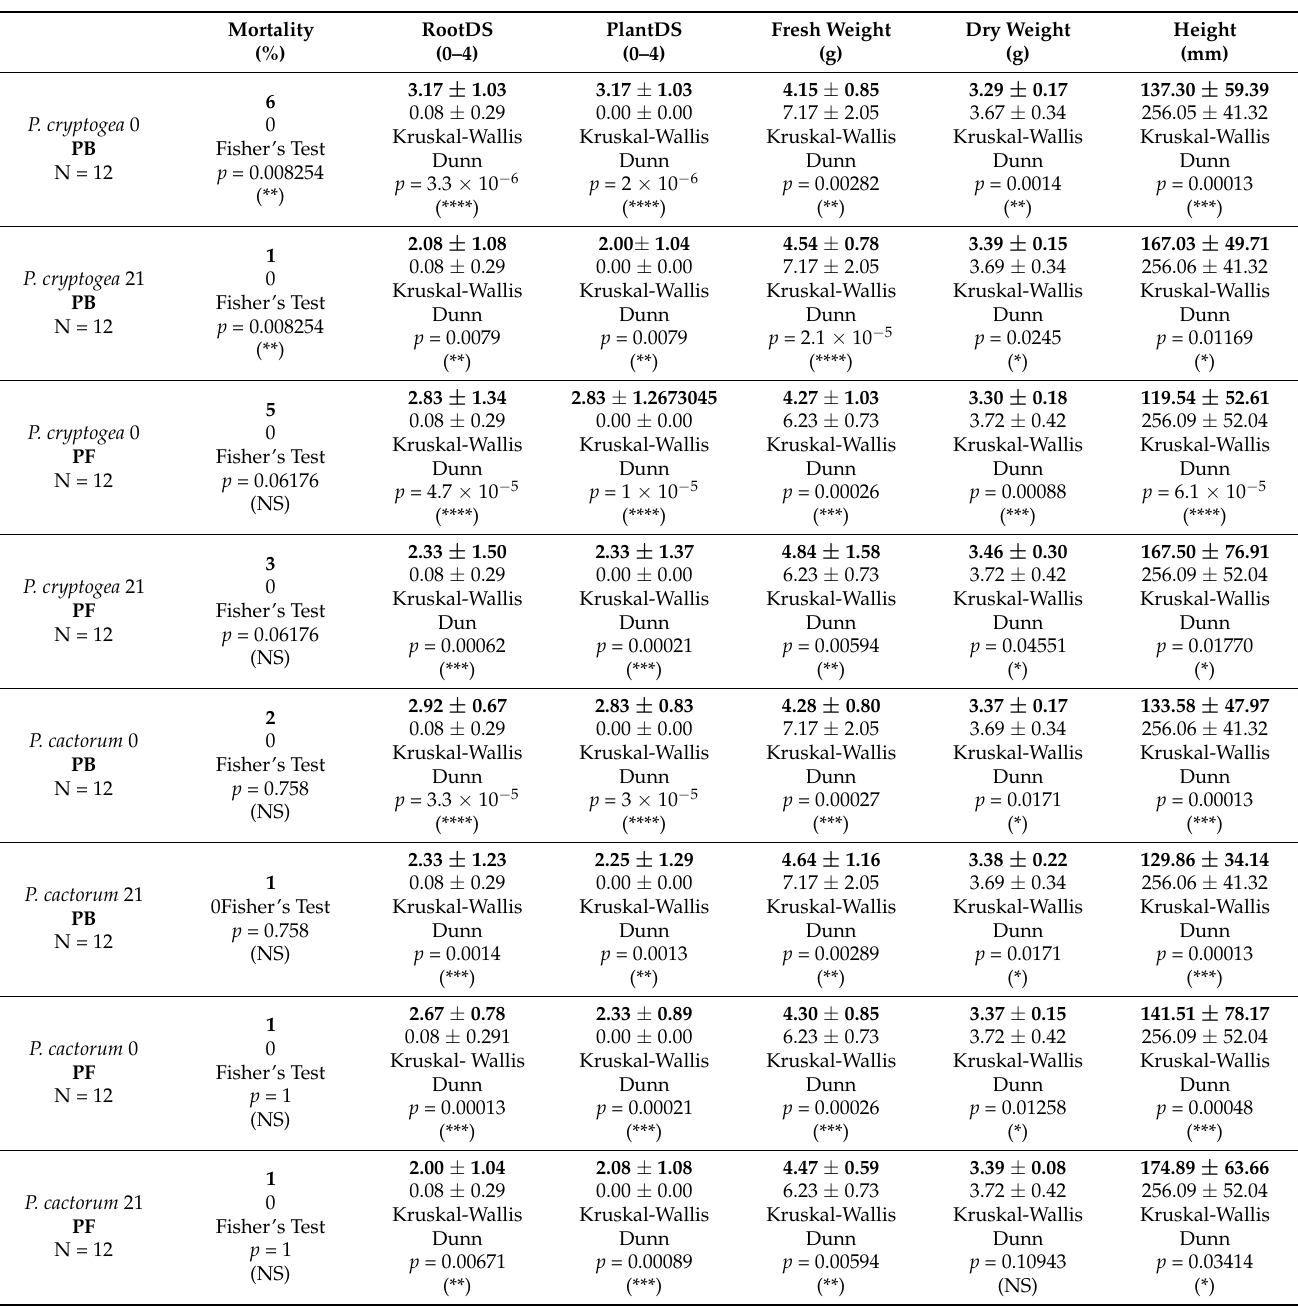
Table 2. Soil inoculation tests comparing plant mortality, foliar symptoms, root disease severity, plant height, and fresh and dry weights for Eucalyptus globulus in substrates Phytophthora cryptogea 21 (21 months after inoculation), P. cryptogea 0 (freshly inoculated), P. cactorum 21 (21 months after inoculation), and P. cactorum0 (freshly inoculated) (rows in bold) compared with controls. Data are means ± SD for each factor and the p-value (for mortality, sample proportions are shown instead of the mean and SD). NS means p > 0.05, * means p ≤ 0.05, ** means p ≤ 0.01, *** means p ≤ 0.001, **** means p ≤